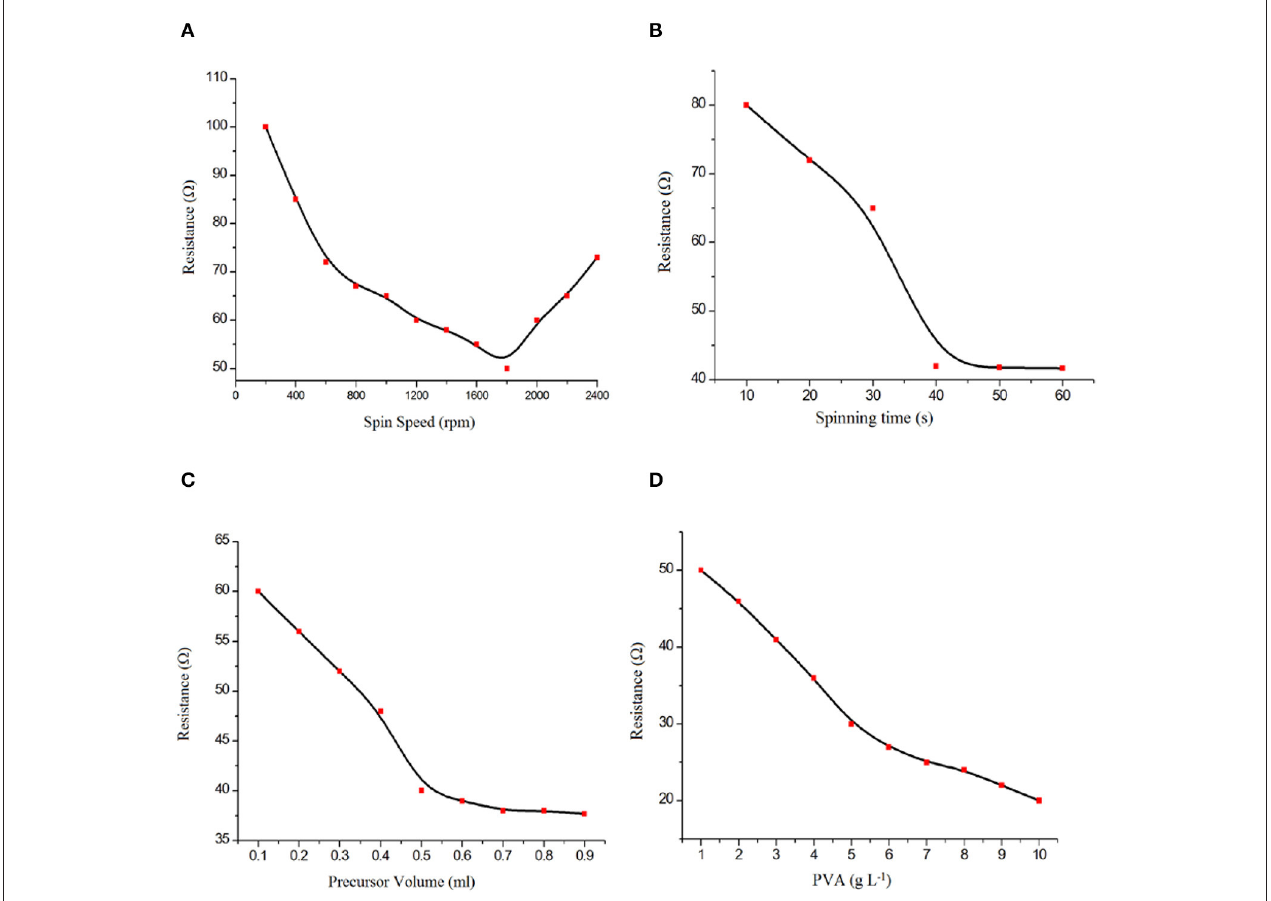
FIGURE 1 | Effect of (A) spin speed, (B) spinning time, (C) precursor volume, and (D) polyvinyl alcohol (PVA) content on PVA/fluorinated tin oxide (FTO)